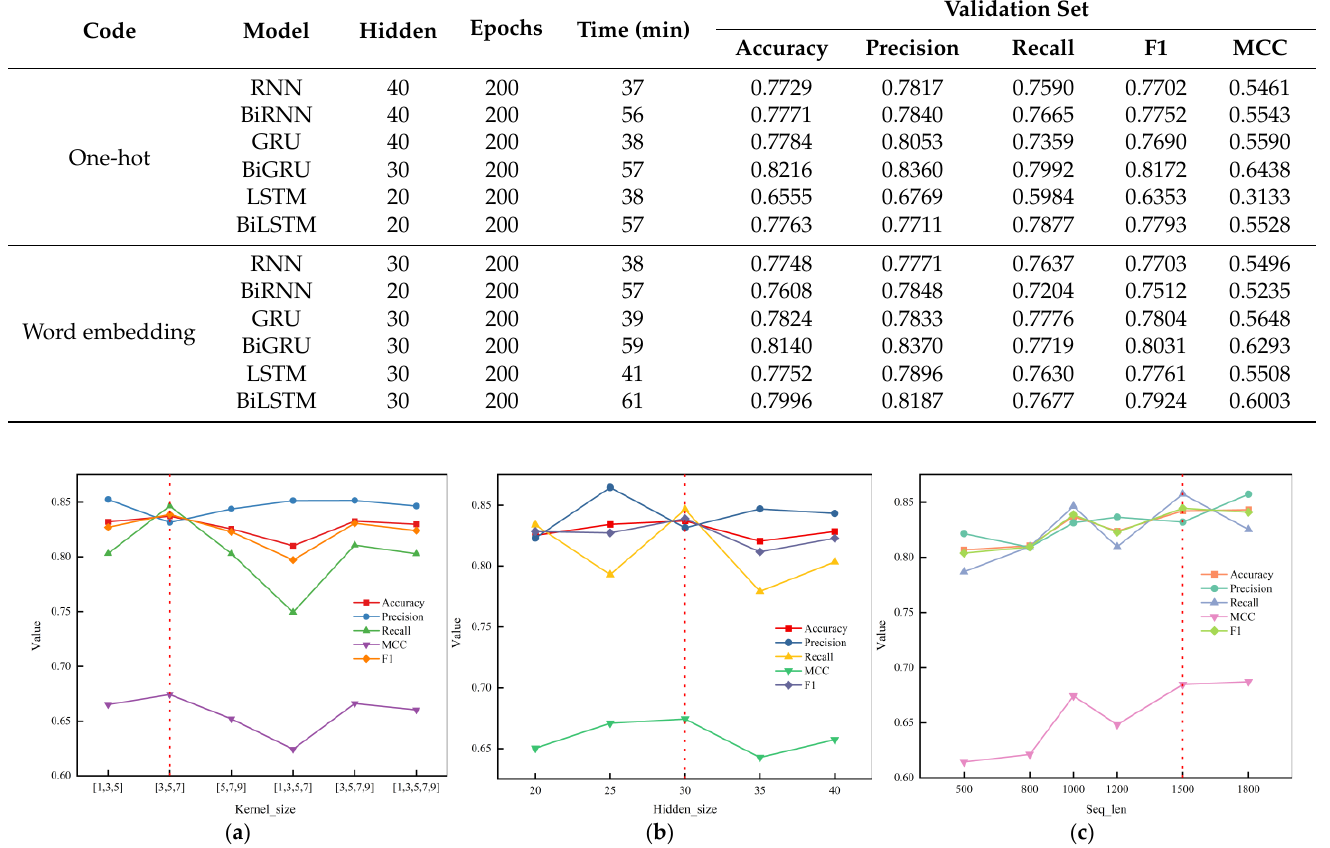
Figure 2. The effect of different hyperparameters on CNN-BiGRU: ( a ) Performance of CNN-BiGRU models with different kernel_size combinations; ( b ) effect of different hidden layer sizes on CNN- BiGRU models; ( c ) performance comparison of CNN-BiGRU models with different sequence lengths. fixed